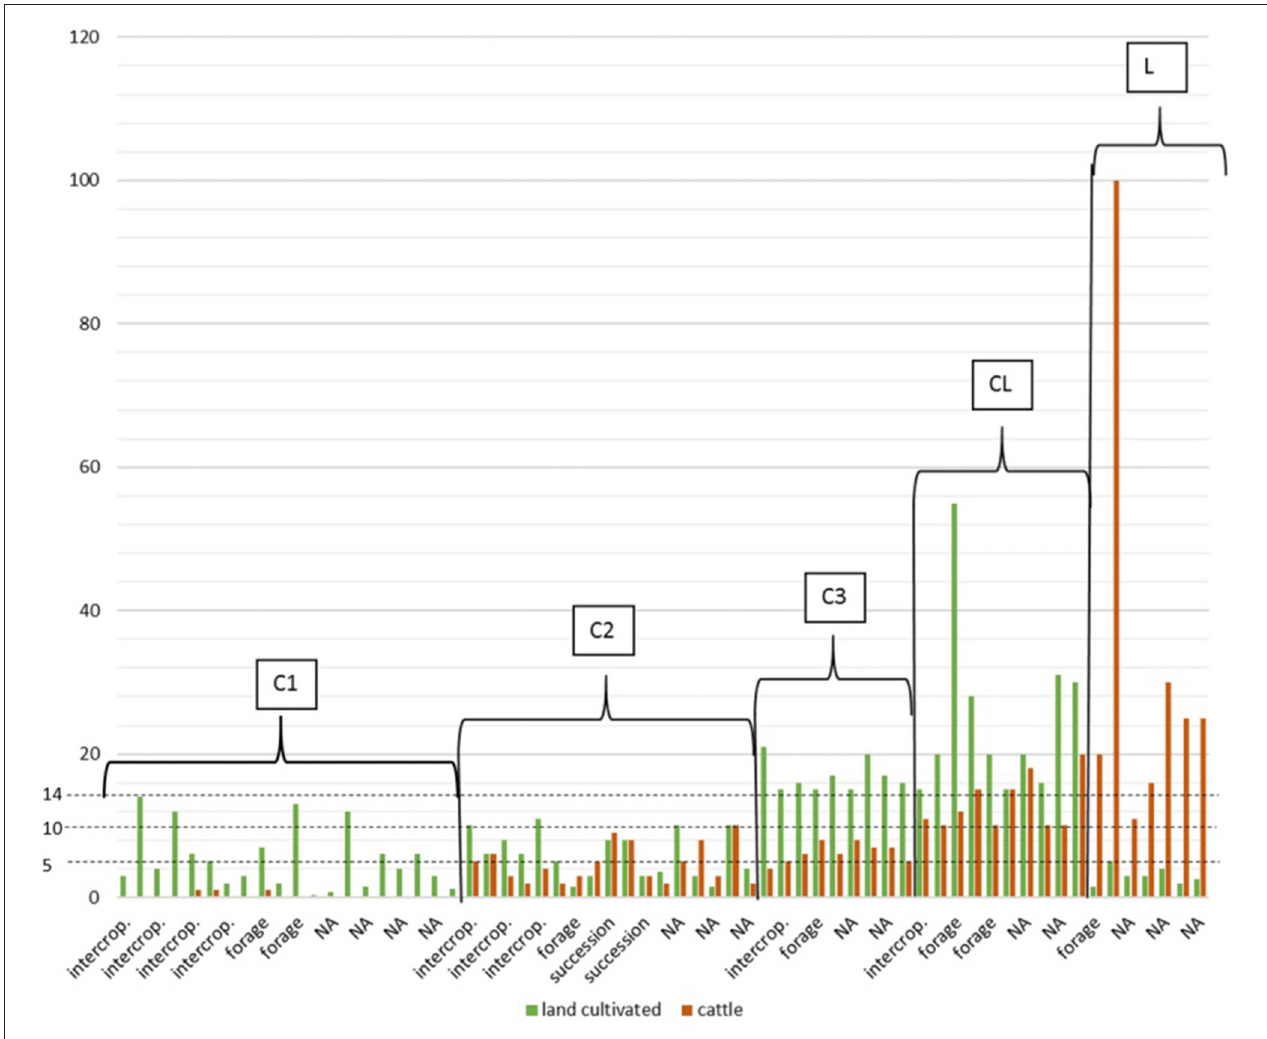
FIGURE 2 | Distribution of the farming system types according to the number of ha cultivated (in green) and the number of cattle (in brown) on the y -axis, and the type of ICS tested in their farmer adaptation trials, or the choice not to take part in the farmer adaptation trials (NA), on the x -axis. The threshold values for cultivated area ( ≤ 5ha for livestock farmers, < or ≥ 14 for crop and crop-livestock farmers) and number of cattle ( < 10 for crop and crop-livestock farmers or ≥ 10 for livestock farmers) are shown on the y